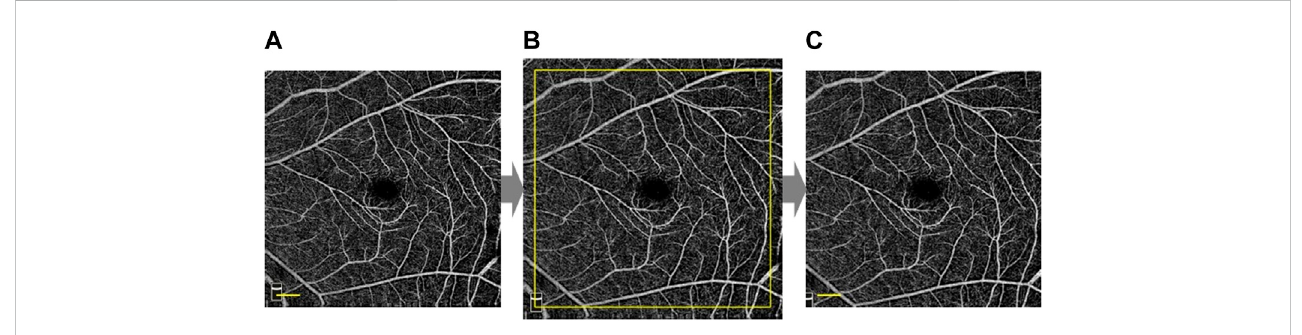
FIGURE 1 Magni fi cation correction of OCTA high myopia image. According to Bennett ’ s formula, the original image (A) was magni fi ed ×1.10 to obtain the magni fi edimage (B) based on AL =26.17mm, and then further cropped to thesize of theoriginal image (C) . Scalebar: 600 μ m. (A) , (B) , and (C) were based on the same OCTA image.